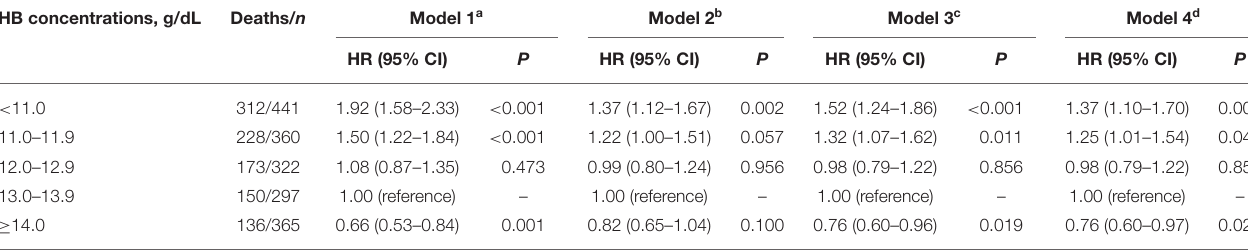
TABLE 2 | HRs (95% CI) for all-cause mortality according to HB concentrations in the older adults form Chinese longevity regions. HB concentrations, g/dL